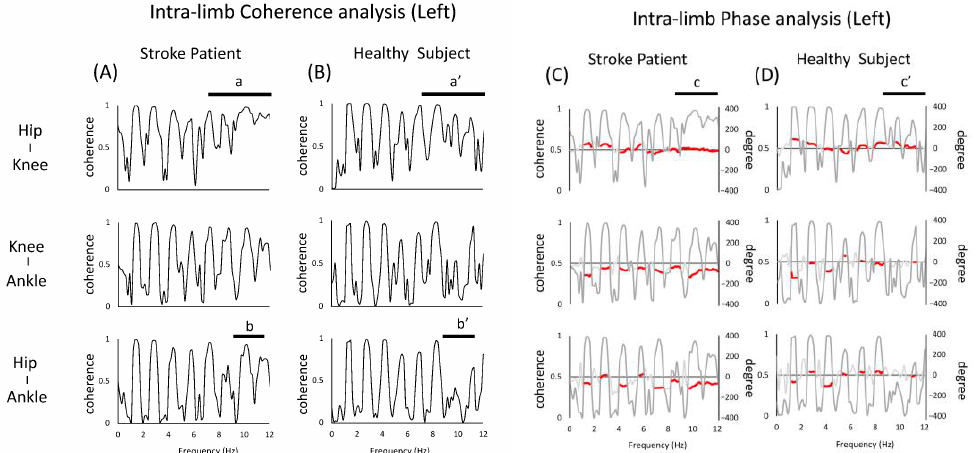
Figure 3. Diagram of the intra-limb (left limb) coherence and phase analysis of the left lower limb. The figure ( A , B ) shows the results of the coherence analysis. The figure ( C , D ) shows the results of the phase analysis overlaid with the results of the coherence analysis (gray line). When the peak coherence is greater than 0.3, the phase results are partially shown with red lines. The top, middle, and bottom rows show the hip, knee, and ankle joint pairs, respectively. In the figure, (a,a’), (b,b’) shows coherence analysis, (c,c’) shows the different parts of the phase analysis between stroke patient and healthy